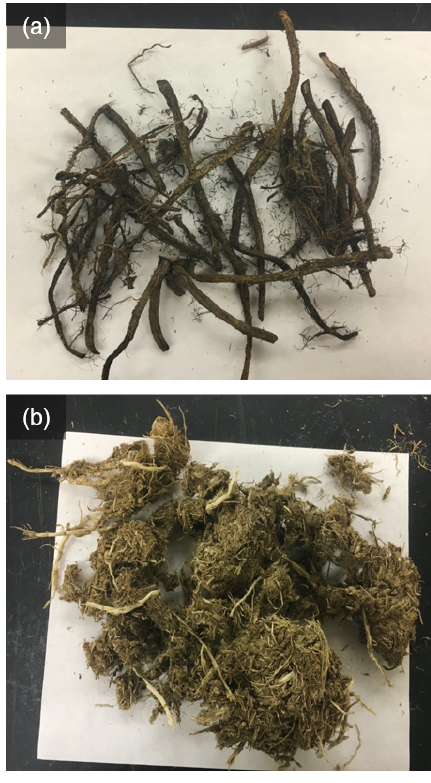
Figure 7. Photographs of belowground biomass root networks at concurrent depths for (a) freshwater species, Peltandra virginica , and (b) salt and brackish marsh species, Spartina alterniflora